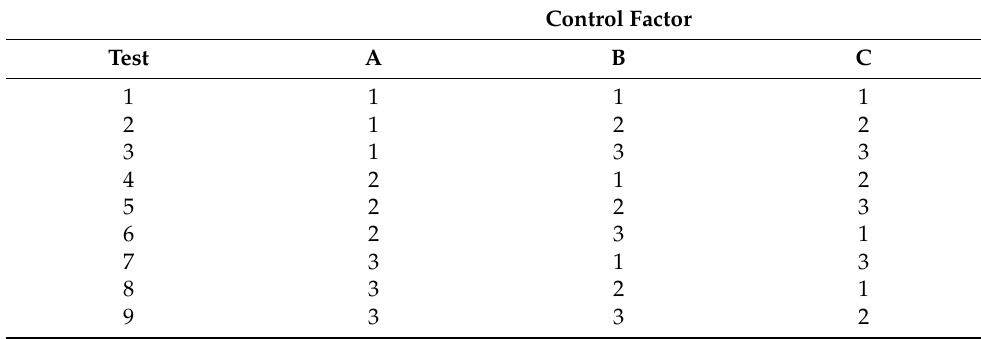
Table 2. Experimental layout using the L 9 orthogonal